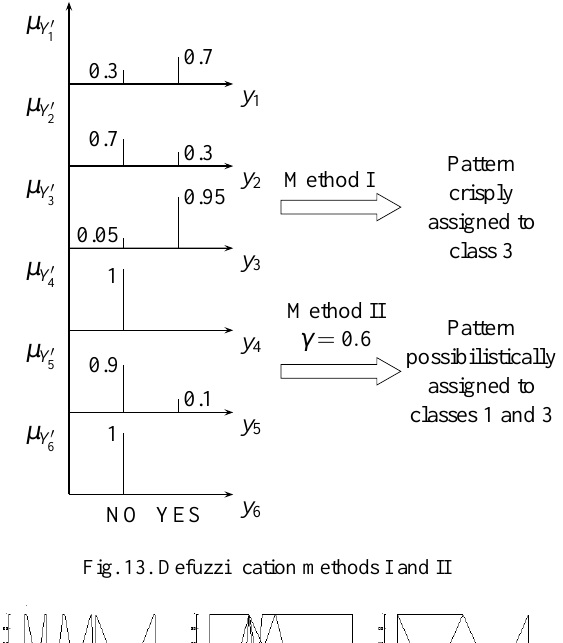
Fig. 13. Defuzzification methods I and II